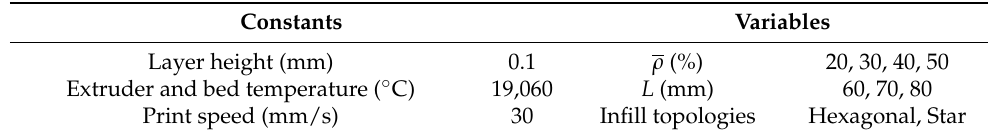
Figure 4. Photograph of ( a ) 3D printing process of lattice infill samples and ( b ) sample mounted on 3-point bending testing setup. Table 1. Parameters for experimental work.